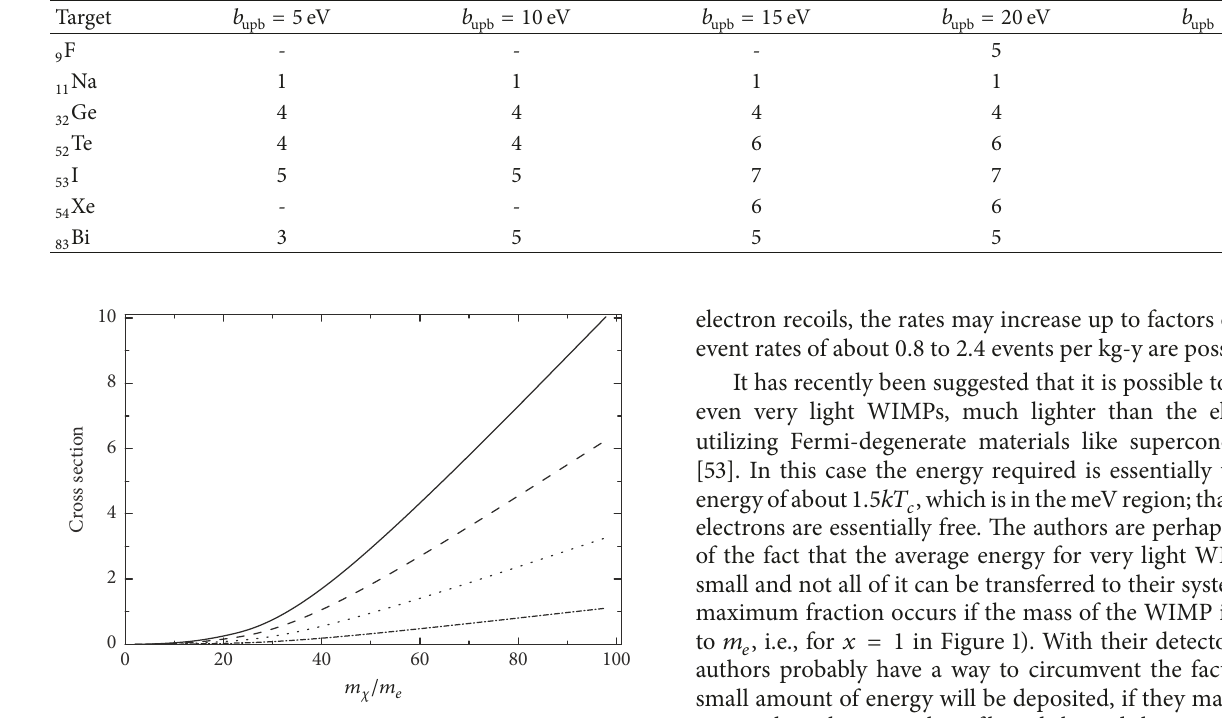
Table 1: The number of electrons with binding energies less than 𝑏 upb for a given set of targets.